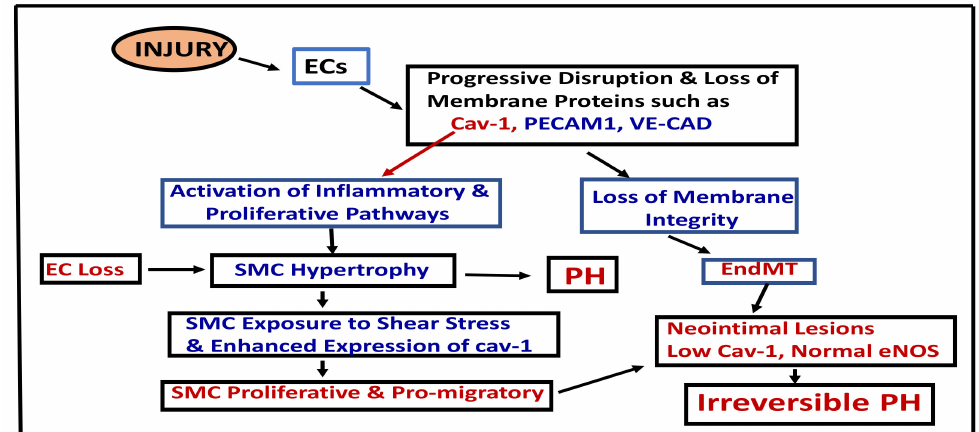
Figure 1. This figure depicts the result of EC damage, loss of endothelial membrane and pathways, leading to irreversible PH. Cav-1 (caveolin-1), ECs (endothelial cells), EndMT (endothelial mes- enchymal transition), PECAM-1 (Platelets’ endothelial cells’ adhesion molecules), PH (pulmonary hypertension), SMC (smooth muscle cells), VE-CAD (vascular endothelial